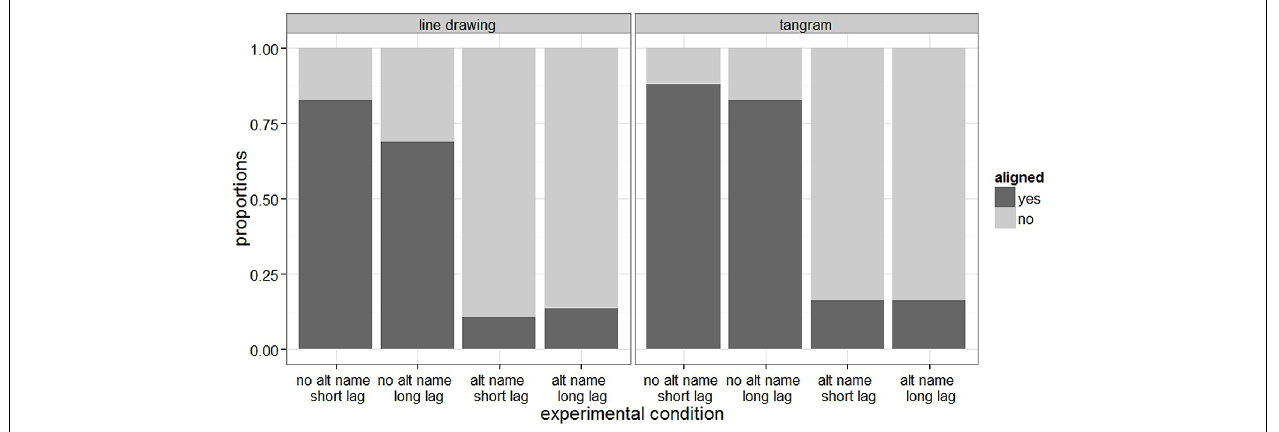
FIGURE 2 | Proportion of aligned responses, i.e., responses where the director used the name that the partner had used previously use to describe the same object/shape, in the two alternative name (alternative name vs. no alternative name) and in the two lag (short vs. long) conditions for line drawings and tangram